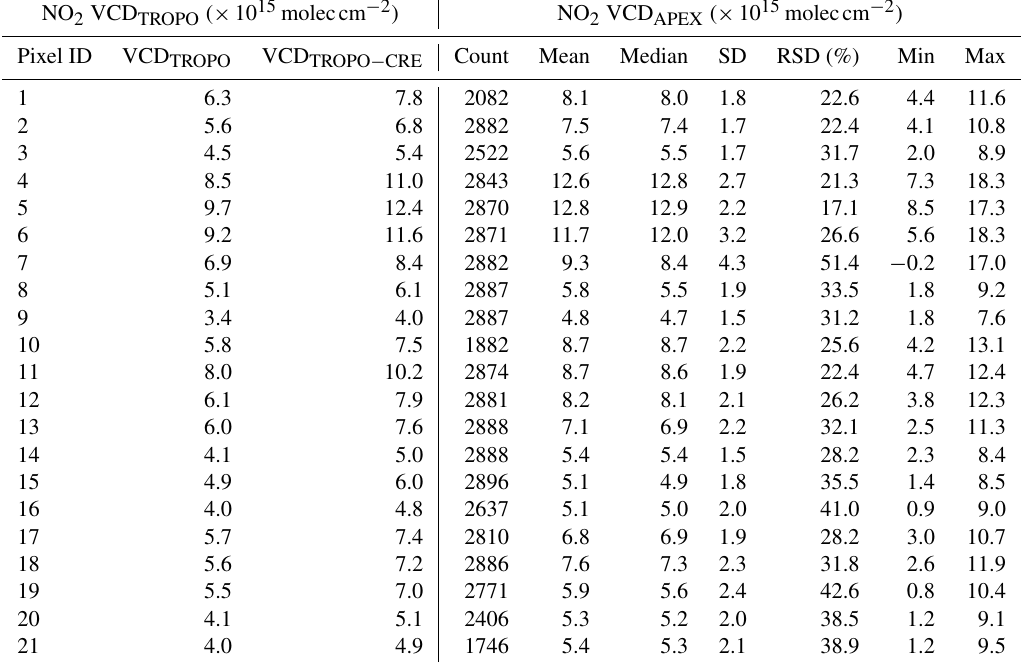
Table A2. Tropospheric NO 2 VCD statistics for coincident TROPOMI and APEX pixels for Flight no. 2, orbit